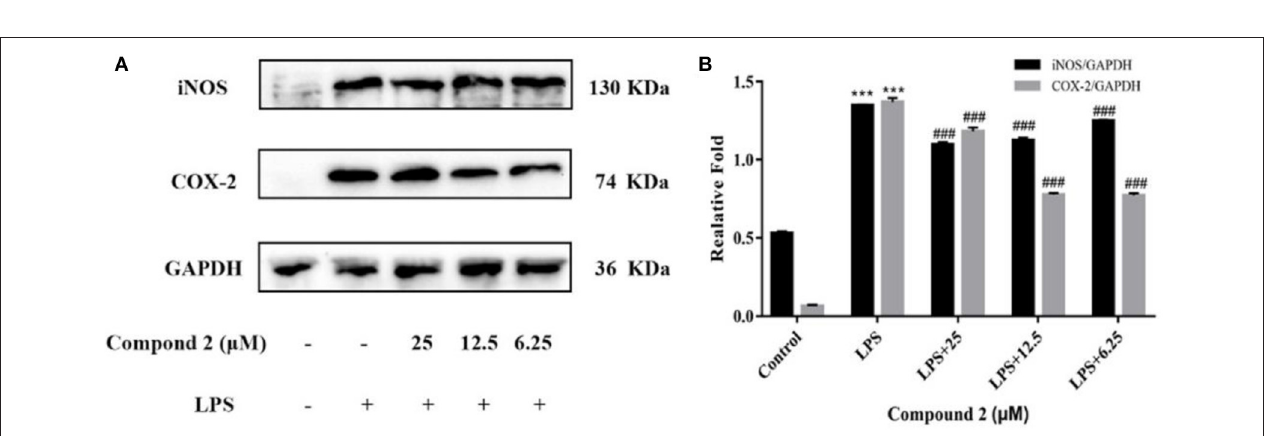
FIGURE 5 | Influences of compounds on NO production for LPS-induced RAW264.7 cells. Compound 2 (A) ; compound 5 (B) ; compound 6 (C) ; compound 14 (D) . Data rendered are the mean ± SD, n = 3. In comparison to the control, *** P < 0.001. In comparison to LPS, ### P < 0.001.